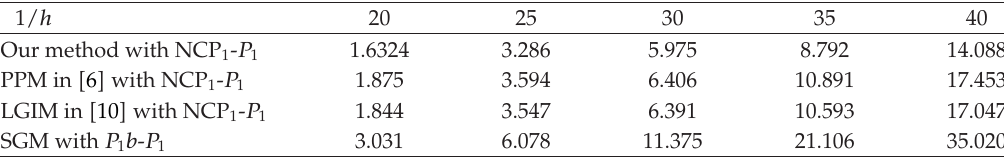
Table 5: CPU time for solving the steady Navier-Stokes equations with di ff erent mesh